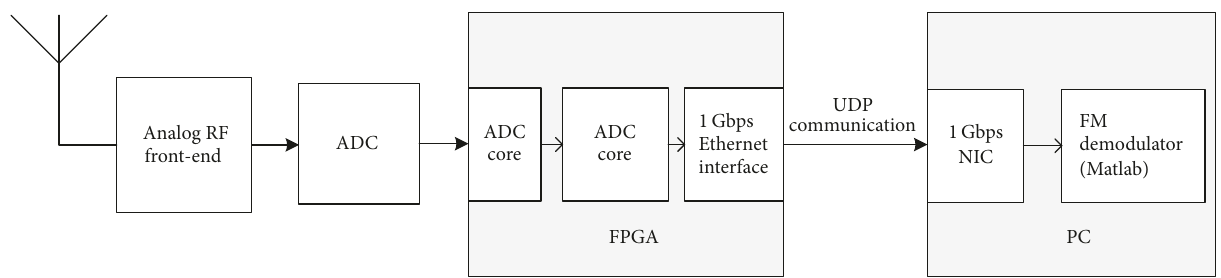
Figure 28: Experimental setup for a digital wideband FM